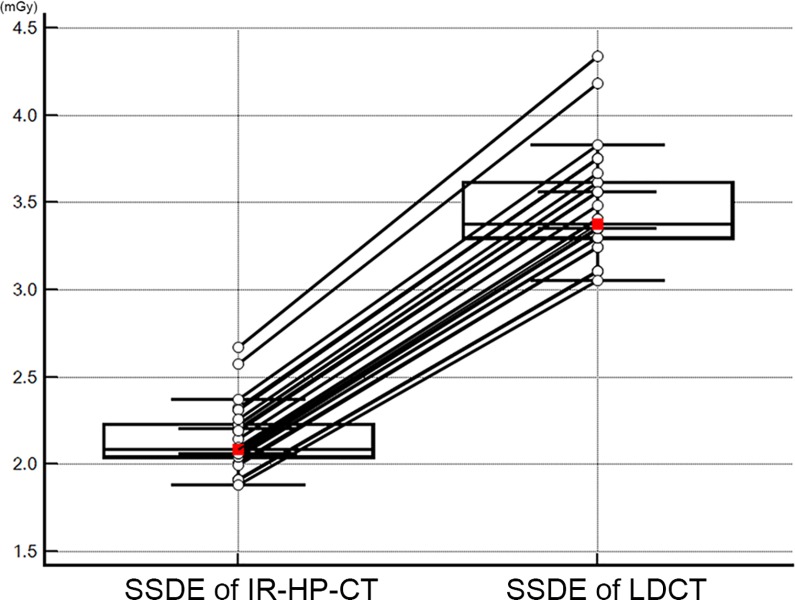
Size-specific dose estimates in each volunteer using LDCT and IR-HP-CT.The mean SSDE was significantly lower using IR-HP-CT (P < 0.001). The central box represents the values from the lower to upper quartile (25 to 75 percentile). The red squares are the means and the middle line represents the median.